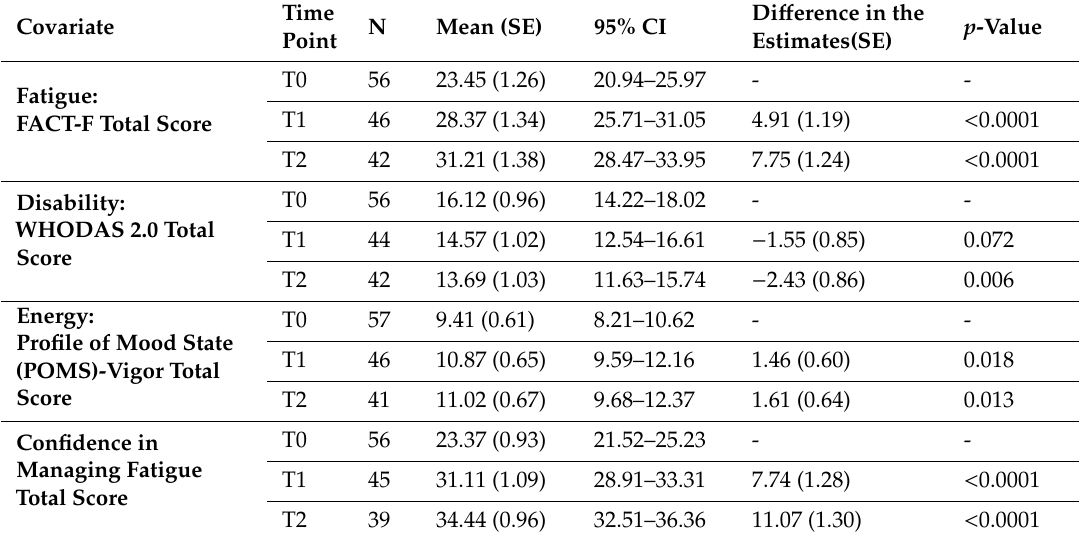
Table 4. Estimated means from linear mixed models.